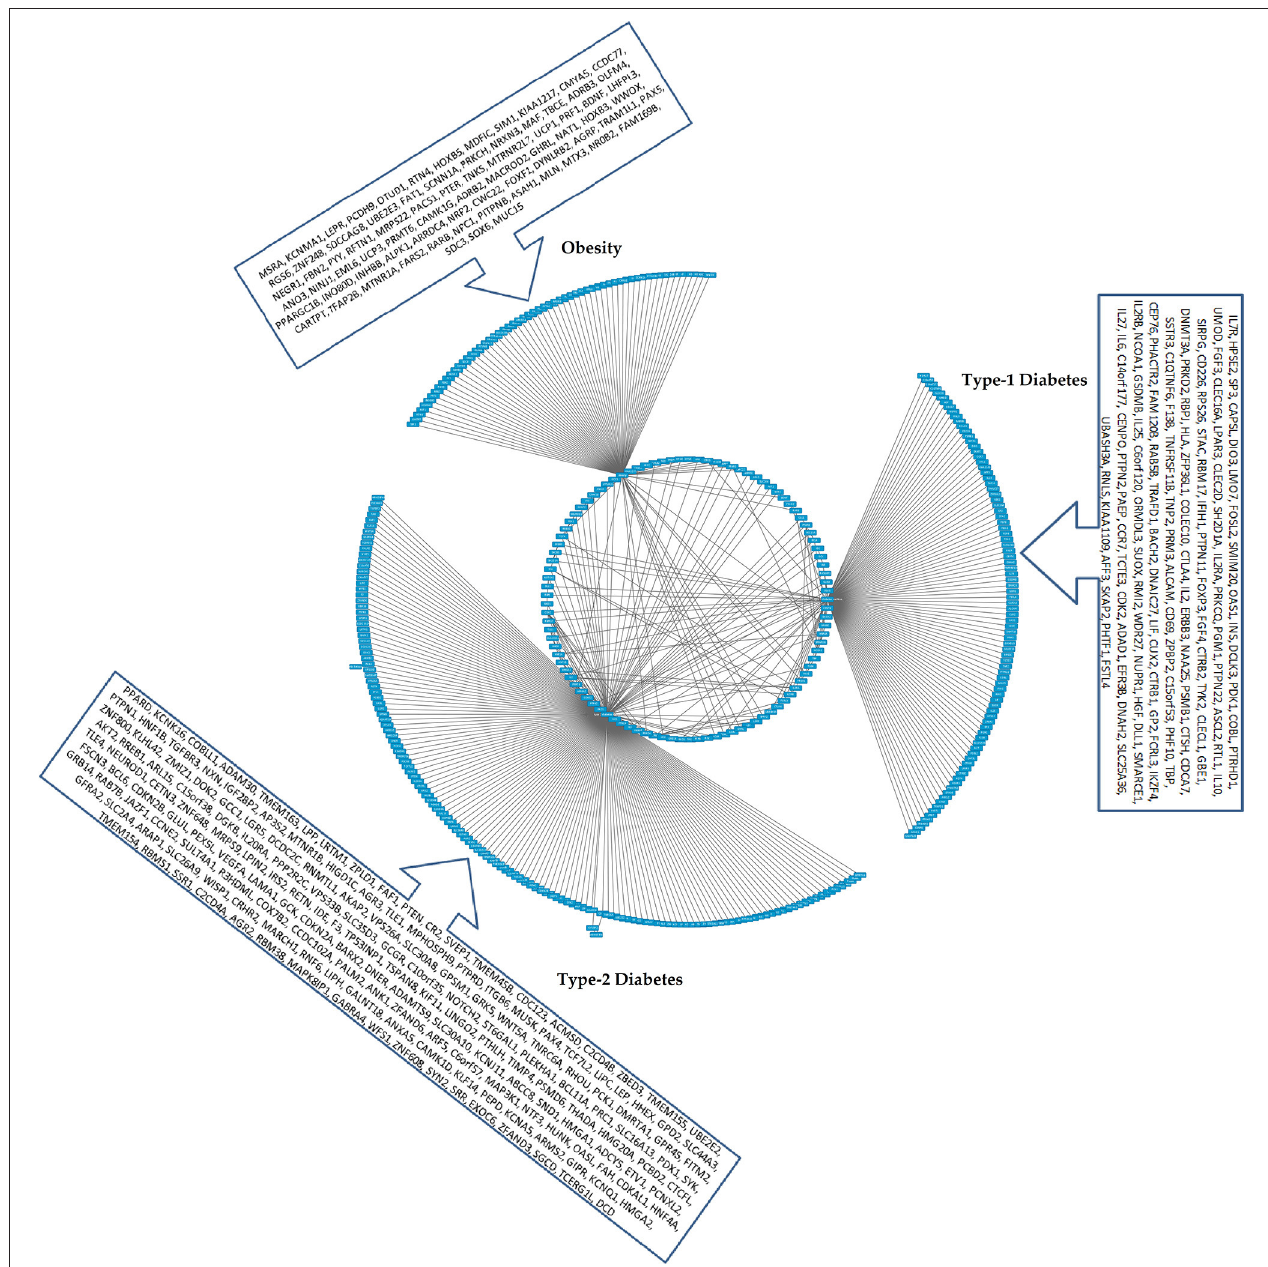
FIGURE 4 | The CHAT generated bundled circular layout with phenotypic associations and the DEGs. For list of DEGs inherent to the pathways and the contexts (nodes and connecting edges), please see Supplementary Tables 2, 3 . The contextual parameters are shown in a horizontal list of nodes below the interaction